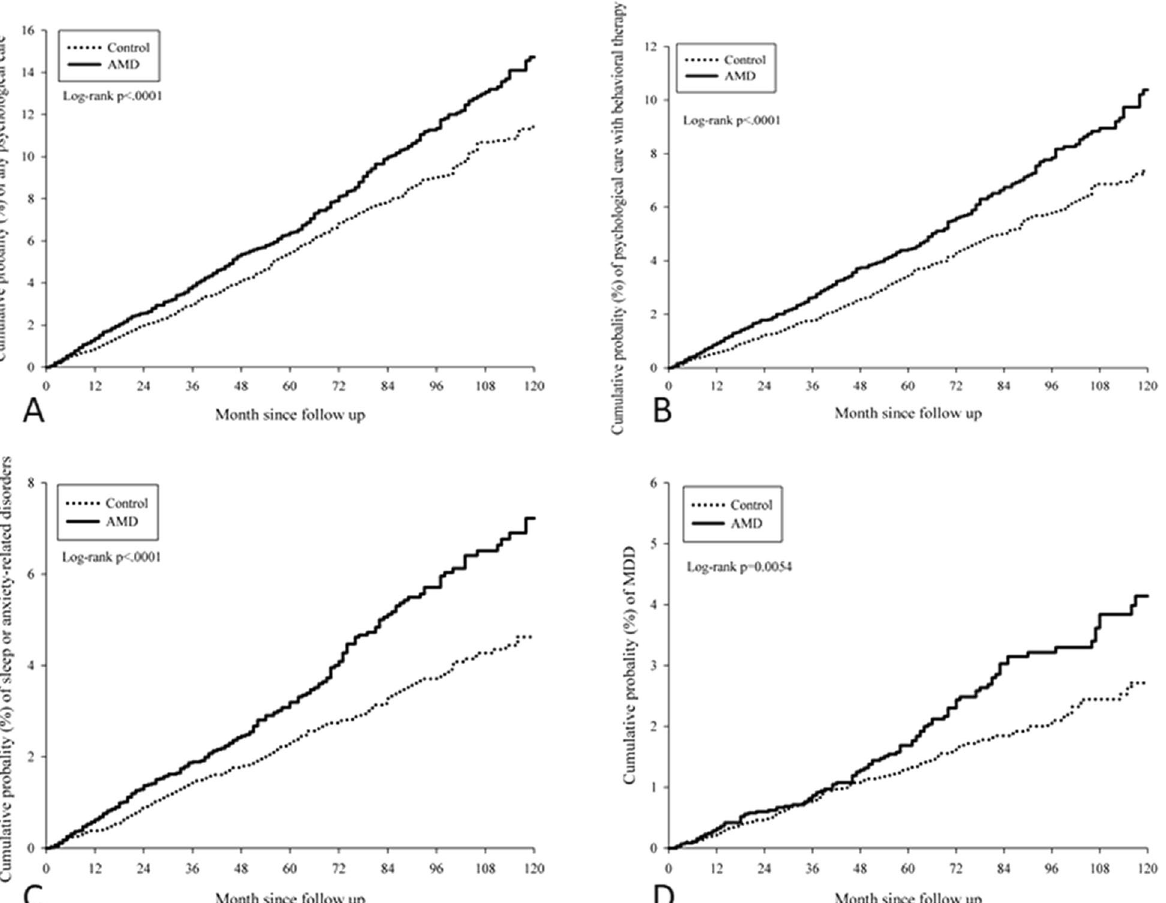
Figure 2. Cumulative probabilities of the mood disorders between the study and control groups. ( A ) Cumulative probability of psychiatric outpatient visit. ( B ) Cumulative probability of behavior therapy. ( C ) Cumulative probability of sleep and anxiety disorder. ( D ) Cumulative probability of major depression disorder. AMD age-related macular